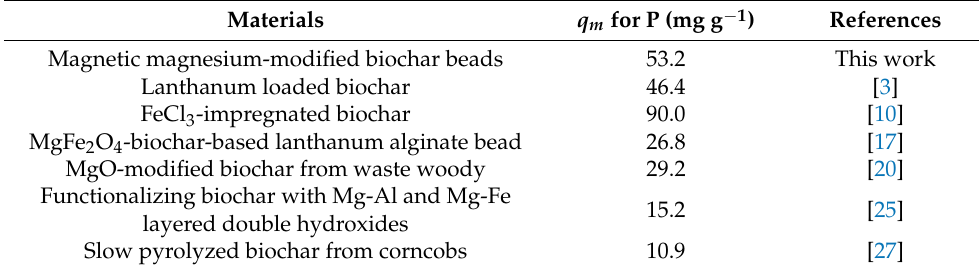
Table 4. q m of relevant adsorbents.